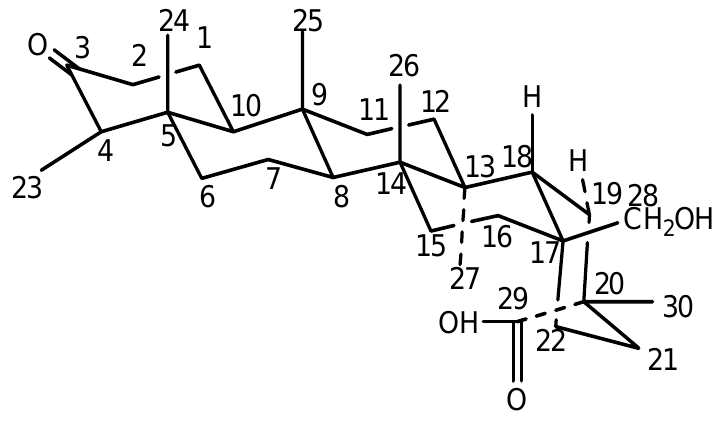
Figure 3. The chair-chair conformation of compound